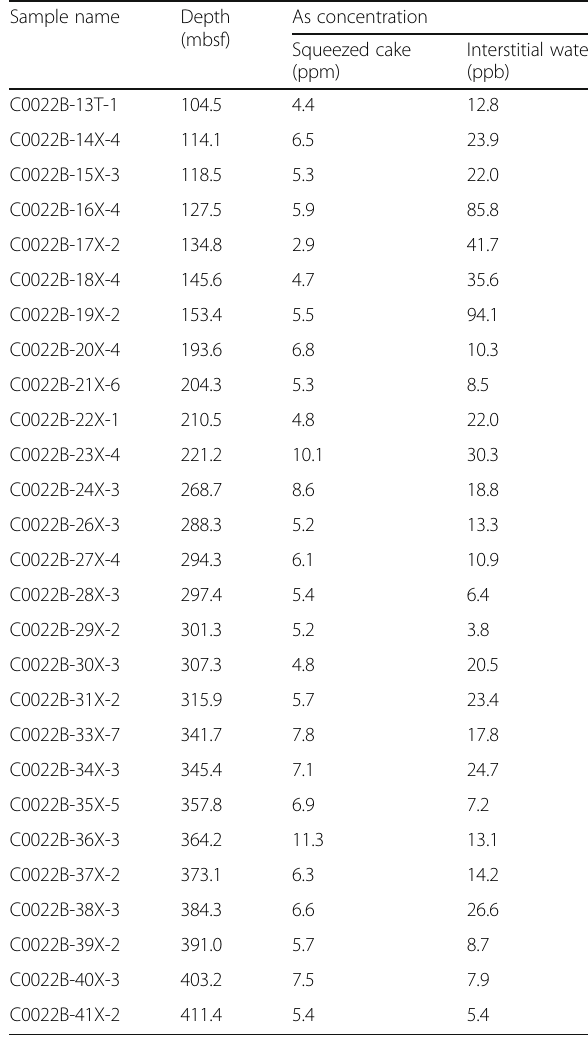
Table 1 Total arsenic concentration of squeezed cake and interstitial water of sediments from the Sites C0002, C0021 and C0022 at Nankai Trough (Continued)